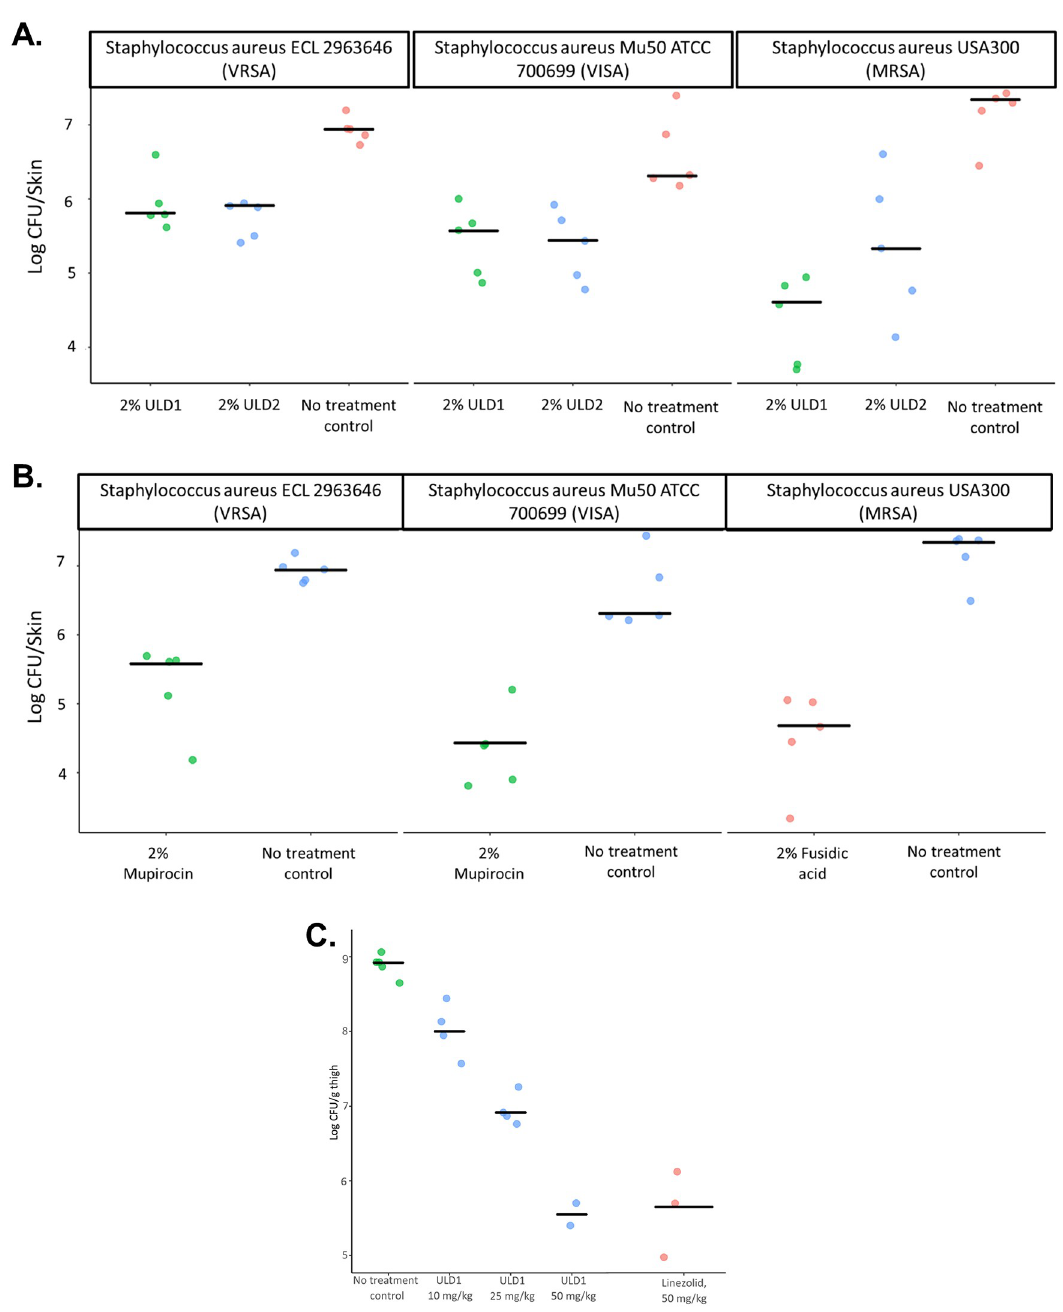
Fig 4. In vivo efficacy of ULD1 and ULD2 in 2 mouse infection models of Staphylococcus aureus . A. and B. In vivo efficacy of ULD1 and ULD2 in a mouse model of skin infection. Figure shows the number of CFUs after twice-daily topical antibiotic treatment (starting at 1 hour postinfection). Three different S . aureus strains were used as inoculum in 5 immunocompetent mice per each group. Fig A and B displays results with ULD1, ULD2 ( A ) and positive control antibiotics fusidic acid and mupirocin ( B ), respectively. Skin tissue CFUs were determined at 25 hours postinfection. CFUs from each mouse are plotted as dots; the black line represents the average CFU in each experimental group. C. Efficacy of ULD1 in a neutropenic mouse infection of S . aureus . The figure shows the number of CFUs in response to antibiotic treatment, using linezolid as positive control. A standard neutropenic thigh infection model was employed with S . aureus VISA ATCC 700699 (for details, see Materials and methods). CFUs from thigh tissue homogenates were determined at 26 hours postinfection. The CFUs from each individual are plotted as dots, black line represents the average CFU in each experimental group. The underlying data for these figures can be found in S2 Data. CFU, colony- forming unit; VISA, vancomycin-resistant S . aureus